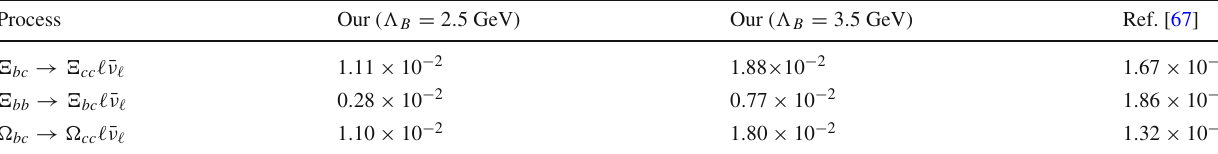
Table 6 Branching fractions of semileptonic decay widths for double heavy baryons Process Our ( (cid:4) B = 2 . 5